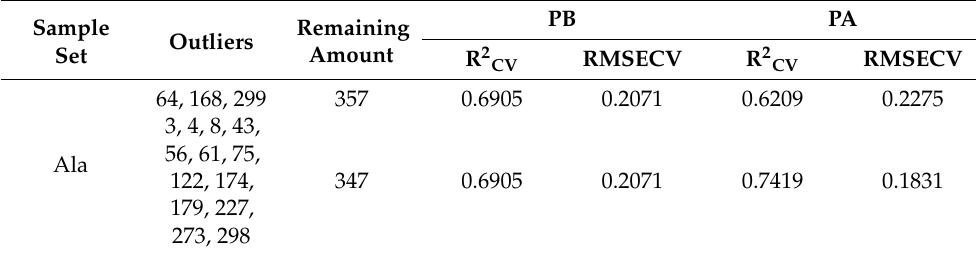
Figure 4. Detection results of abnormal Ala content in beef at the NIR band. Table 2. Detection results of abnormal beef samples based on the Monte Carlo method.